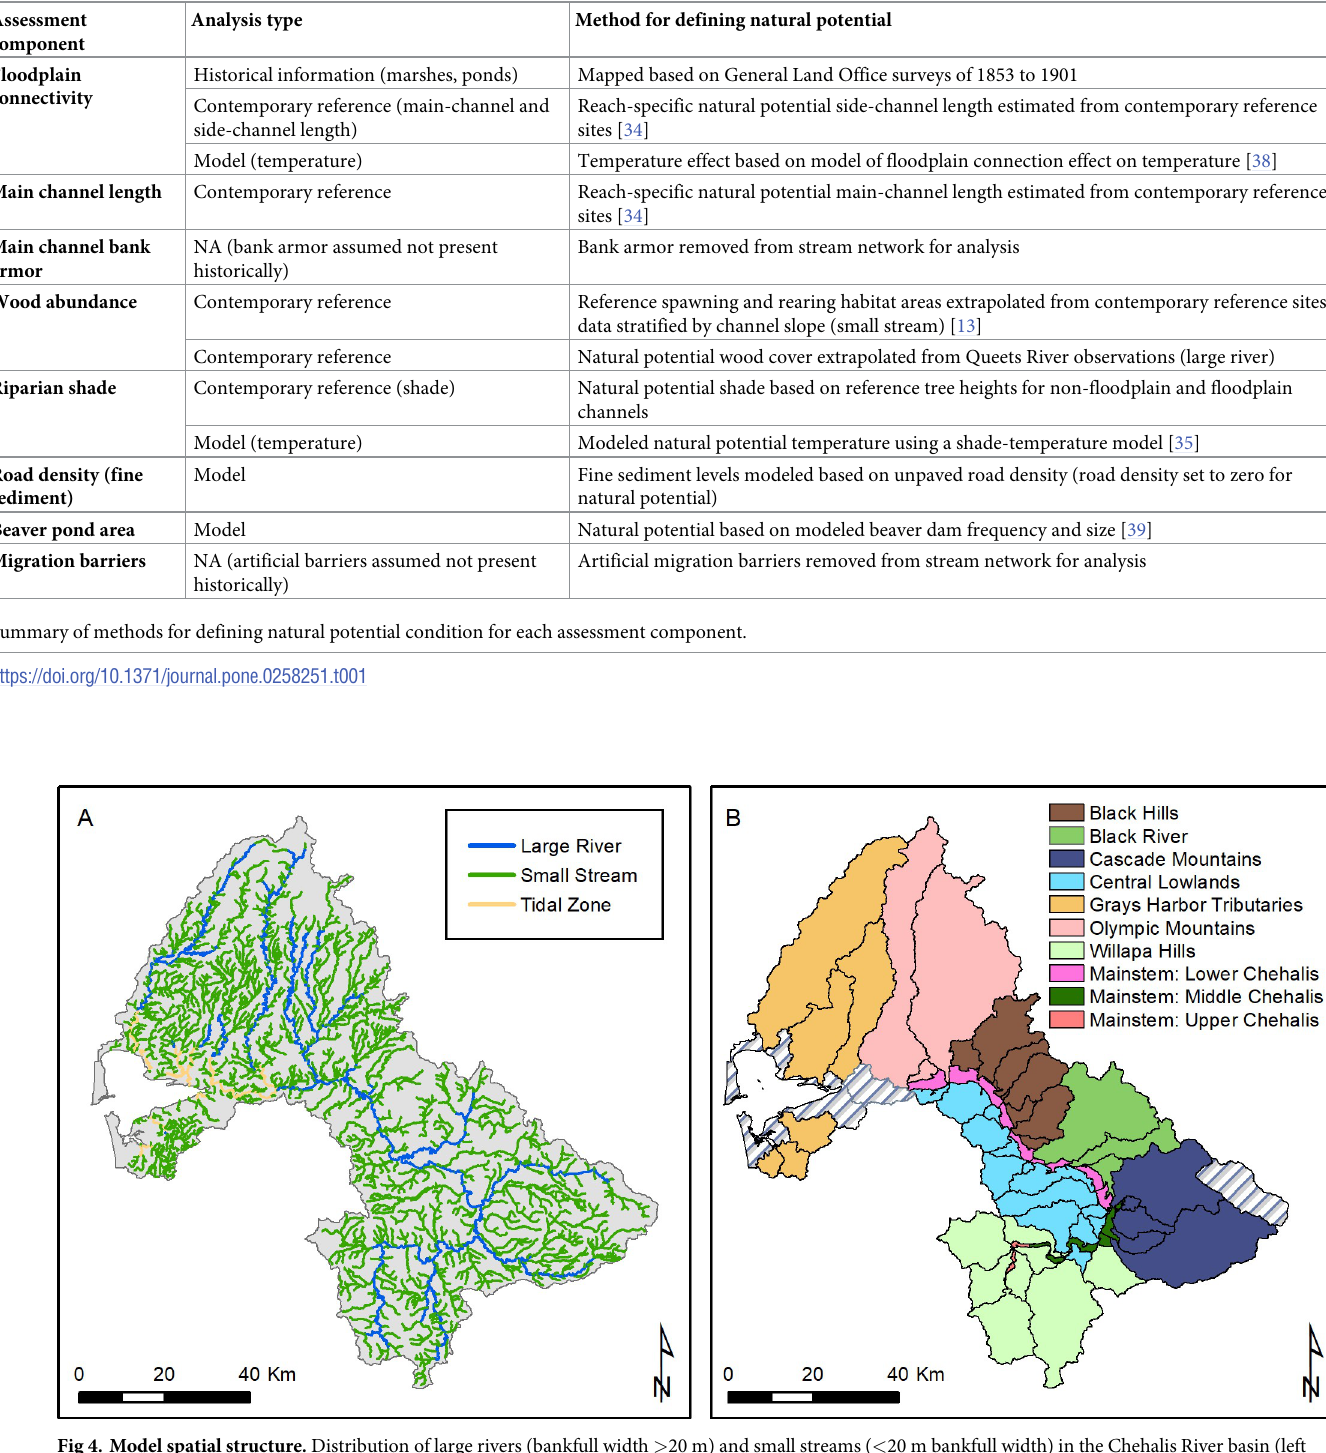
Table 1. Reference condition methods.